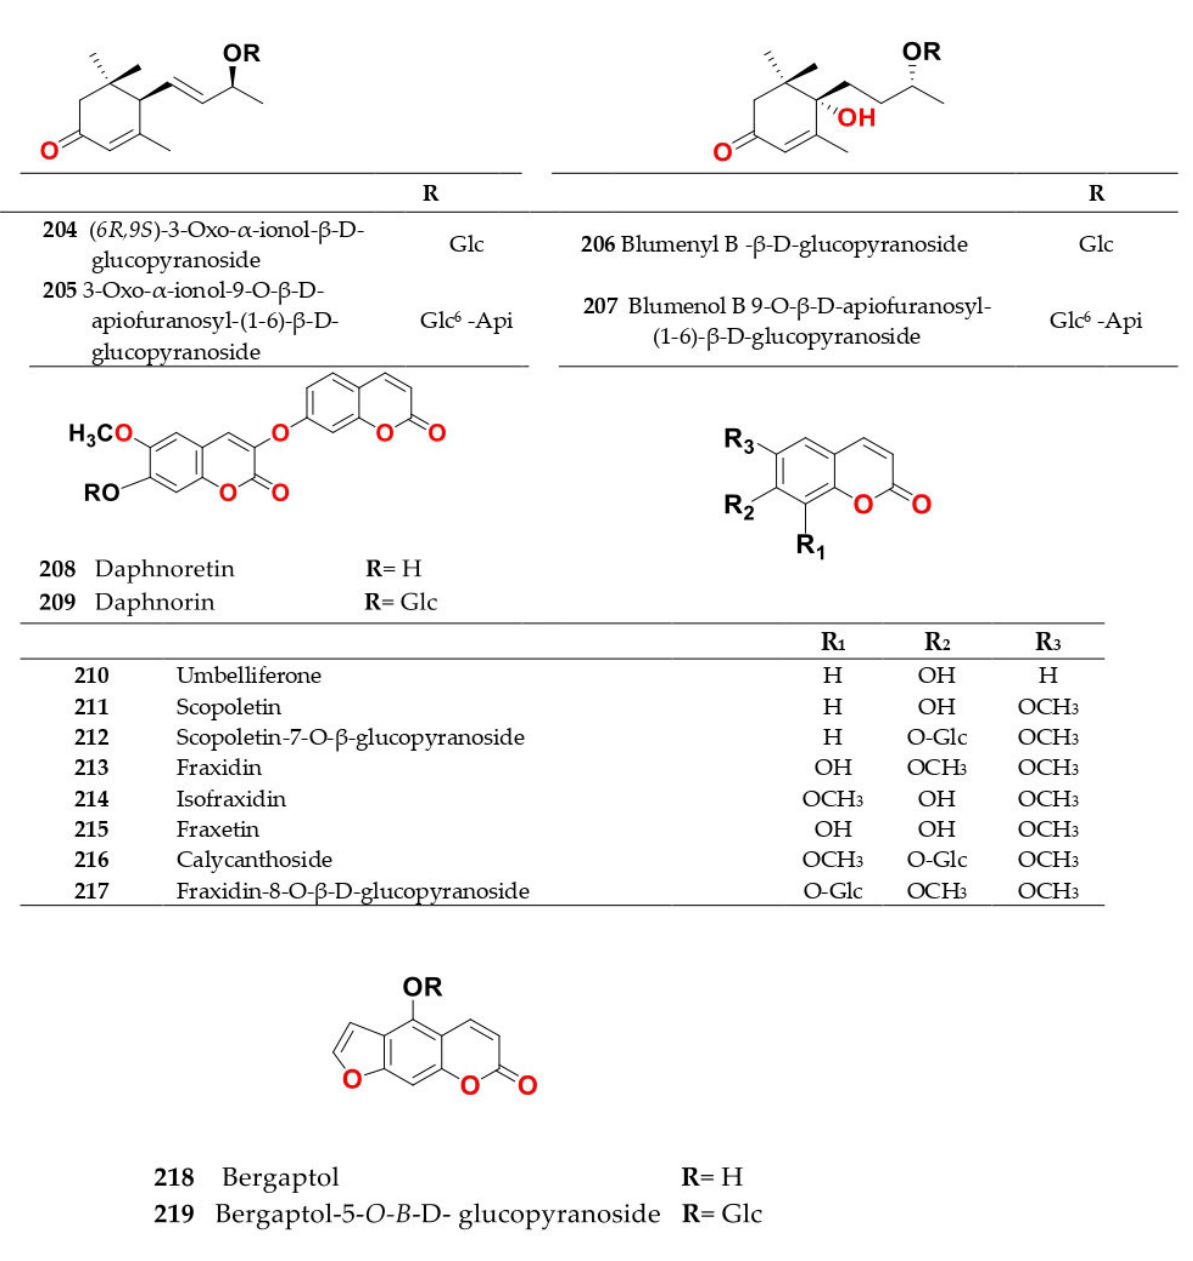
Figure 16. Chemical structure of megastegmanes (cont.) and coumarins isolated from genus Salsola. 4.2. S. baryosma (Schult.) Dandy (Caroxylon imbricata var.